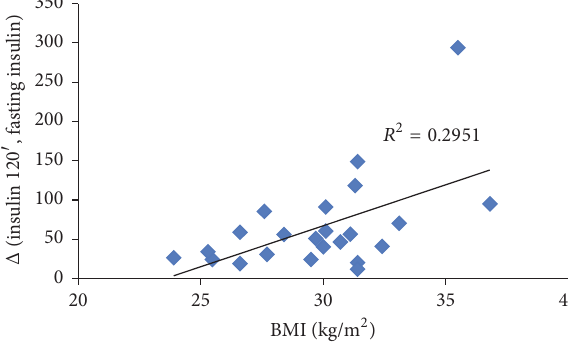
Figure 1: Correlation between BMI and insulin increase from fasting to 120 minutes after OGTT without inositol in the whole sample. 𝑝 =